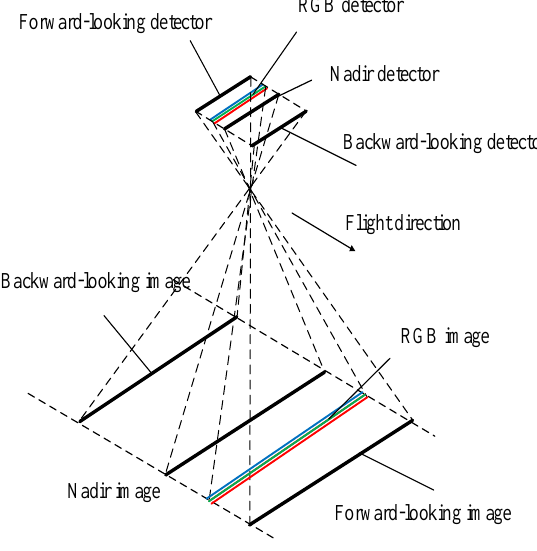
Figure 1. Three-line array camera mapping schematic As shown in Figure 1, three-line array surveying and mapping camera has three detectors, which are projected on the ground